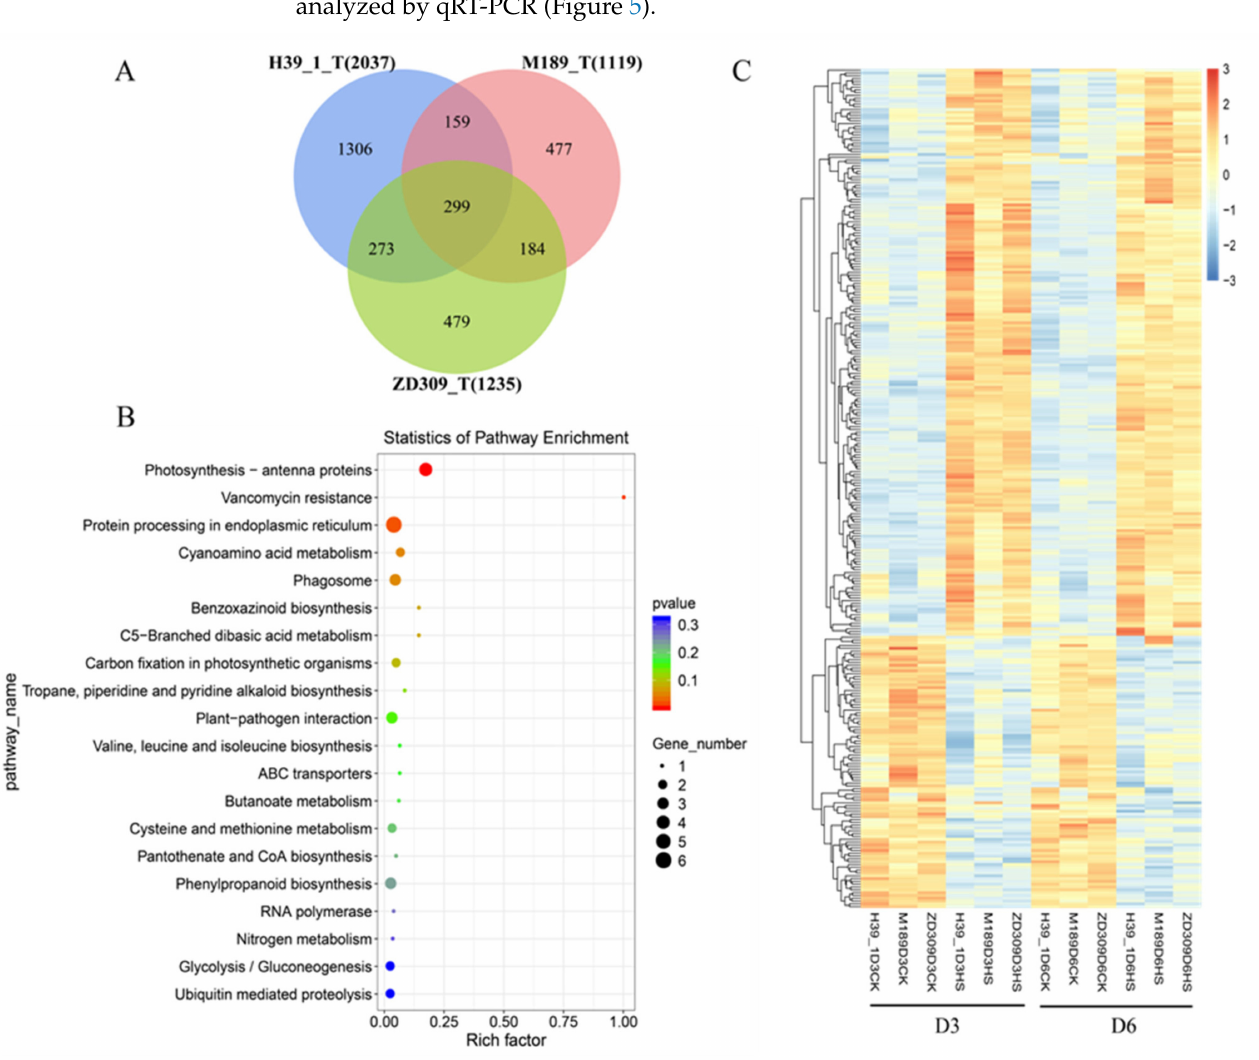
Figure 4. The conserved DEGs identified between the two heat treatments. ( A ) Numbers of DEGs between the two heat treatments in the tested three genotypes; ( B ) Kyoto Encyclopedia of Genes and Genomes (KEGG) enrichment analysis for between the two heat treatments in the tested three genotypes. The x-axis indicated the rich factor, and the y-axis indicated pathway; ( C ) expression patterns of the identified 299 conserved DEGs. The color scale at the right of the figure indicates the gene expression levels transformed by log 10 (FPKM +